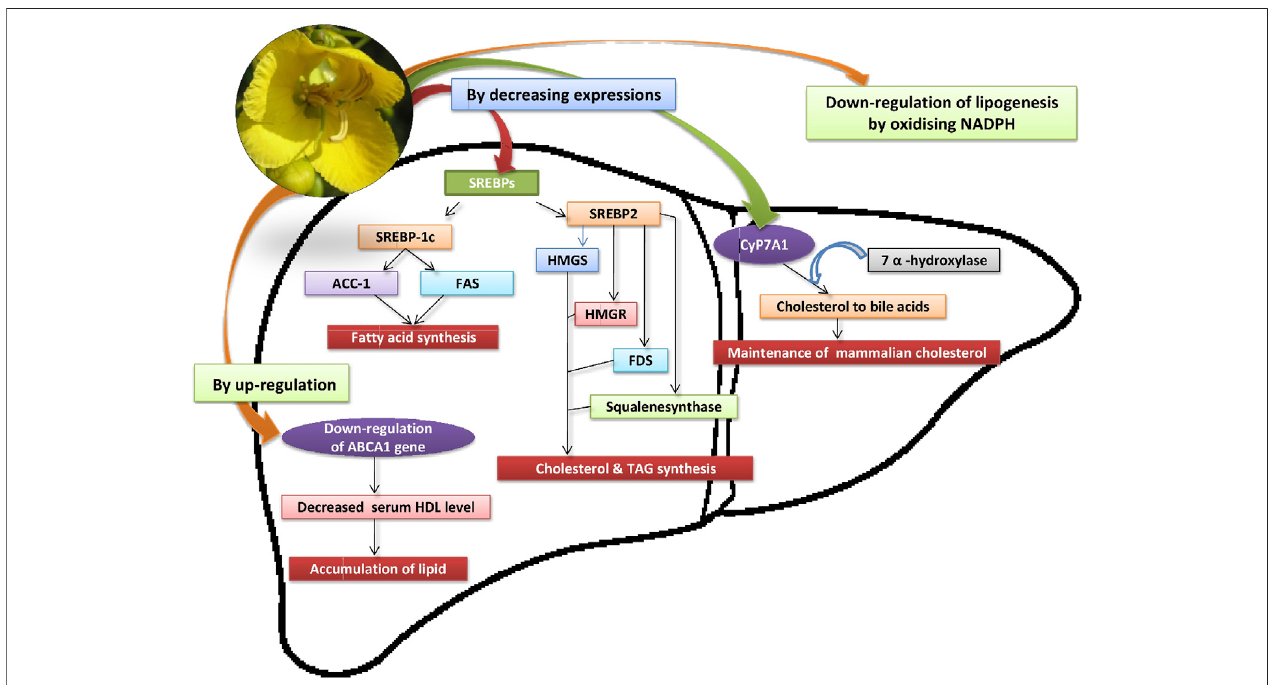
FIGURE 7 | Effect of Senna auriculata (L.) Roxb. fl ower extract on gene and protein expression.